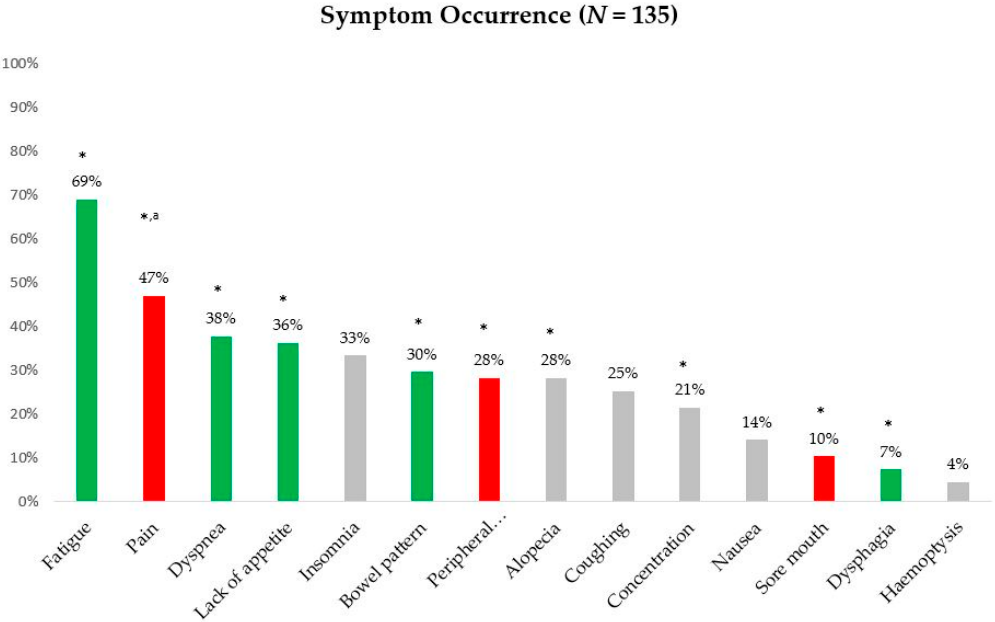
Figure 1. Occurrence of lung cancer (LC) symptom. Green bar, lack of energy symptom group; red bar, pain symptom group. * Statistically significant at p < 0.05 in the association between each symptom and functioning domains. a Pain indicated reports of pain in the chest, arm and shoulder, and other parts.